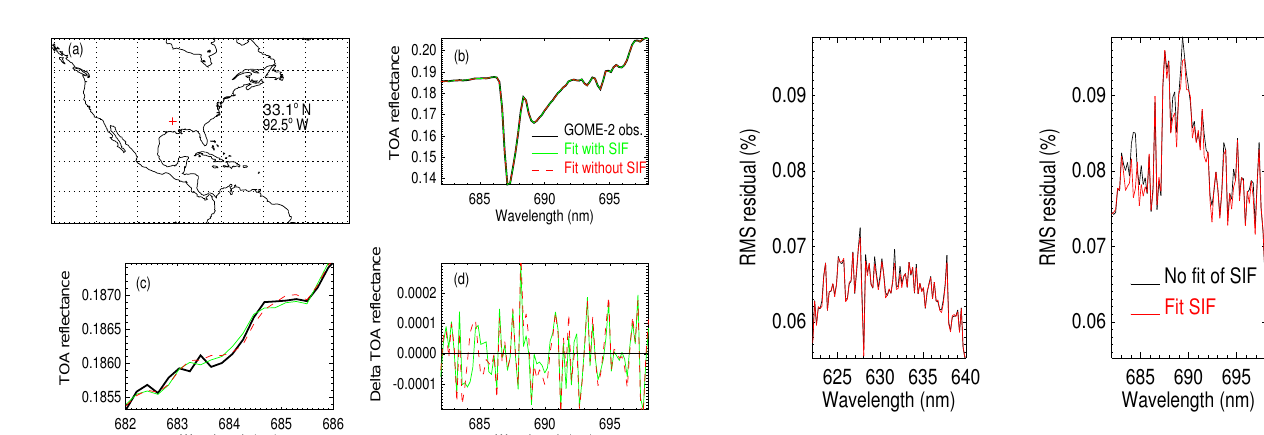
Figure 5. Fluorescence retrievals from simulated data ( y axis) using wavelengths between 682 and 692nm along with wavelengths sur- rounding the O 2 γ band (left) and using wavelengths between 682 and 686.5nm (right) for an instrument with FWHM = 0.5nm and with the nominal noise model. Fluorescence is averaged over the fitting window used in the retrieval (different for left and right panels) and compared with the “truth” ( x axis) averaged in the same way. Standard deviations are shown with vertical bars. Different symbols are shown for the various values of chlorophyll content (5, 10, 20, 40µgcm − 2 ) and different colors are for the different values of leaf area index (0.5, 1).